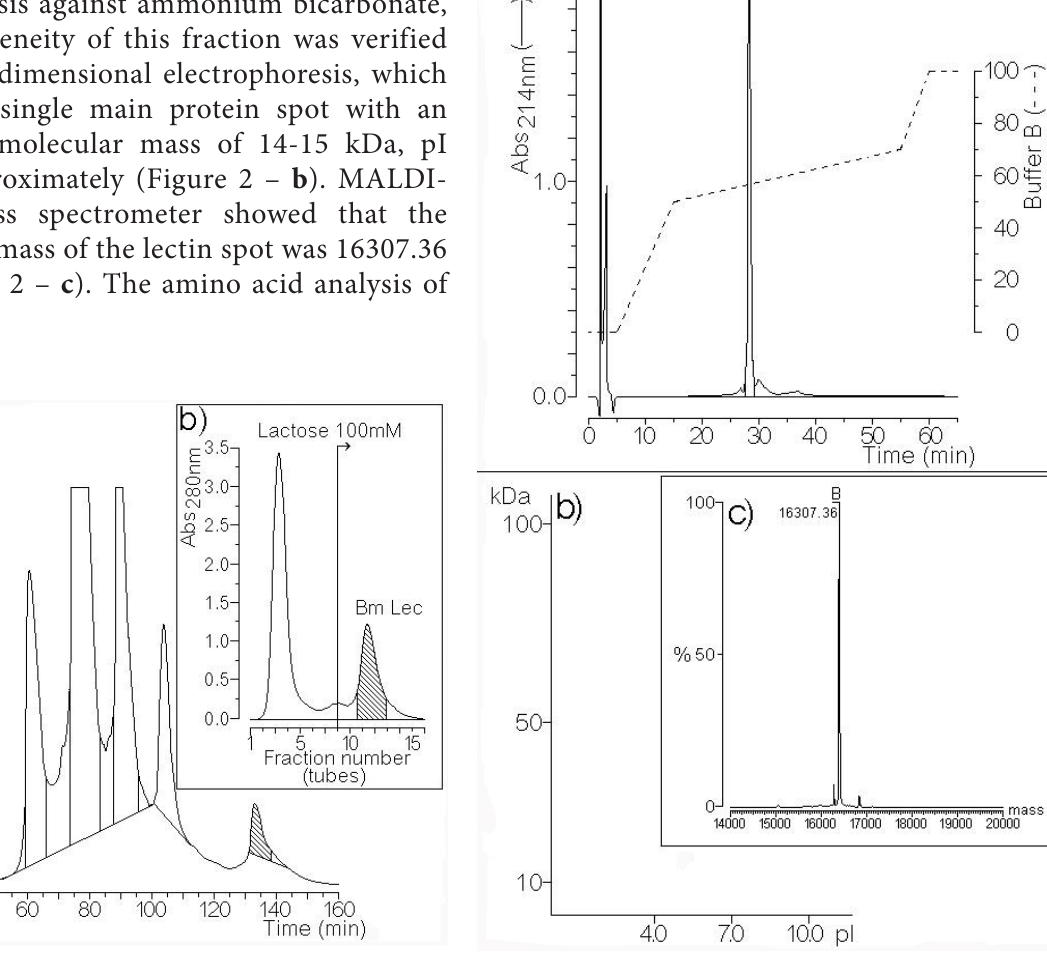
Figure 1. ( a ) The chromatographic profile of the fractionation of whole venom in molecular exclusion HPLC using an AP-1 column (1 x 60 cm) packed with superdex 75. Approximately 30 mg of whole venom was dissolved in 450 mL of ammonium bicarbonate buffer (0.2 M, pH 7.8) and the resulting solution was centrifuged at 4500 x g for one minute. The supernatant was then applied to the column. The elution of the samples was done using the ammonium bicarbonate buffer, and the chromatographic run was monitored at 280 nm. ( b ) The fractionation of BmLec by affinity chromatography using a lactose gradient. The main activity was found in the signaled peak designated as BmLec.